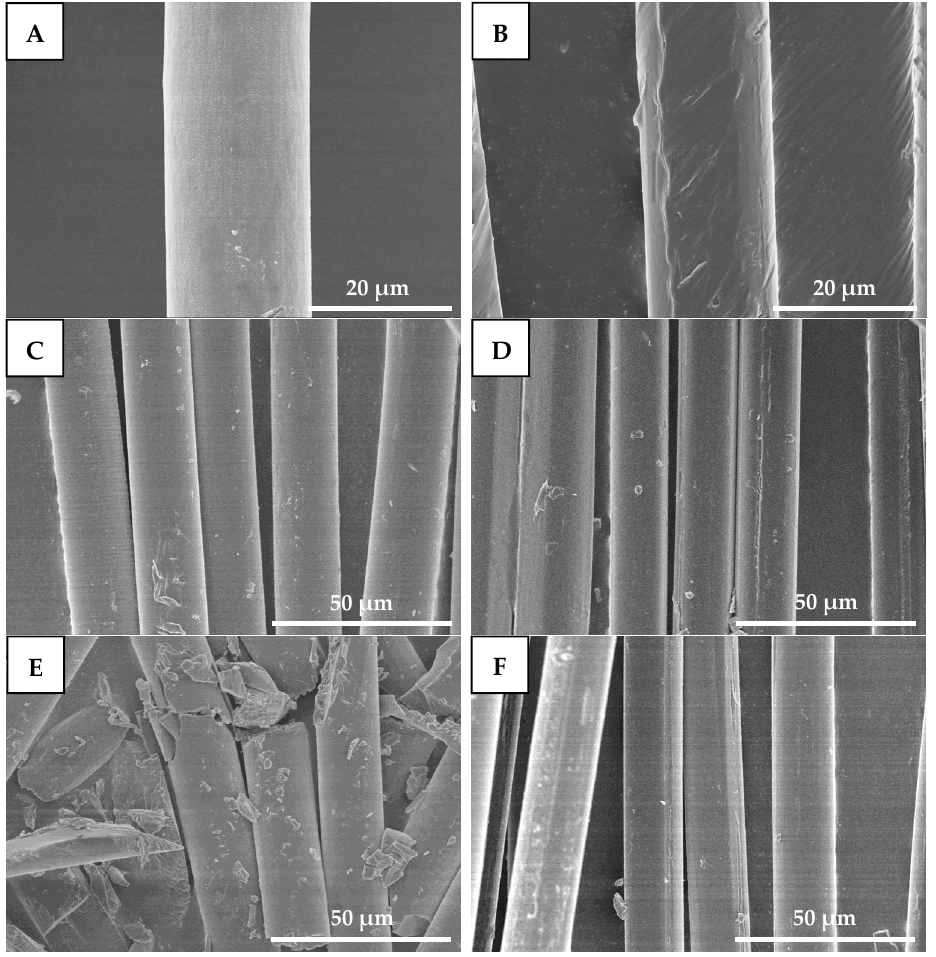
Figure 9. SEM micrographs of drawn − fiber hydrolyzed for different times (( A ) 0 h, ( C ) 8 h, and ( E ) 32 h) and SC − 190 hydrolyzed for different times (( B ) 0 h, ( D ) 8 h, and ( F ) 32 h), ( A , B ) 2000 × , ( C – F ) 1000 ×